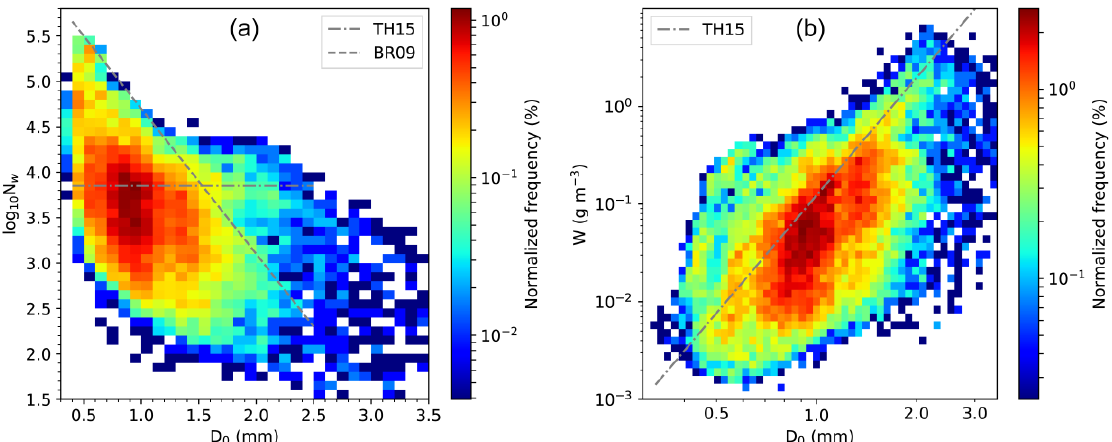
𝑁 𝑤 − 𝐷 0 and (b) 𝑊 − 𝐷 0 N w − D 0 and ( b ) W − D 0 domains. 10 10